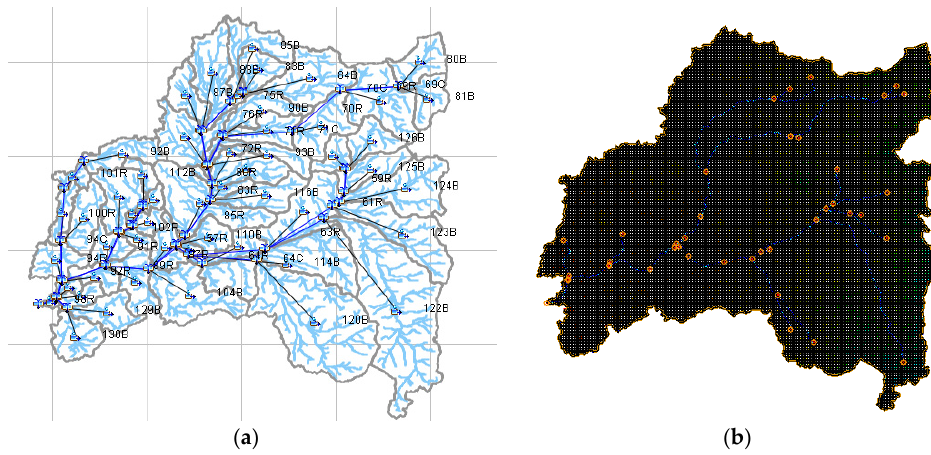
Figure 9. ( a ) HEC-HMS and ( b ) GSSHA models for the Makkah watershed.